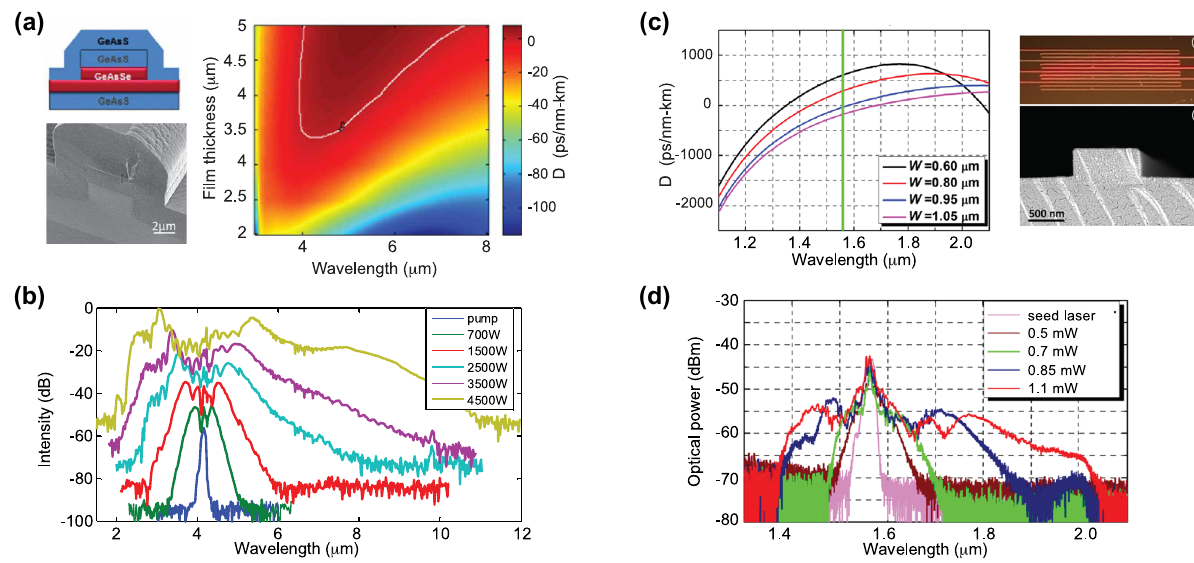
Figure 13: SCG in chalcogenide waveguides. (a) Schematic (top) and SEM image (bottom) of the Ge and calculated dispersion as a function of the wavelength and core film thickness for the fundamental TM at an etch depth of 50% and a fixed waveguide width of 4 μ m. (b) Experimental SC at the waveguide output for different pump powers for TM mode. (c) Simulated dispersion of GeSbSe waveguides with varying widths and a fixed core thickness of 0.4 μ m, and top-view optical microscope image and SEM cross-section image of the GeSbSe waveguide. (d) SC generation of a 21 mm long GeSbSe waveguide with varying average input power. Panels (a) and (b) adapted from [60]. Panels (c) and (d) adapted from